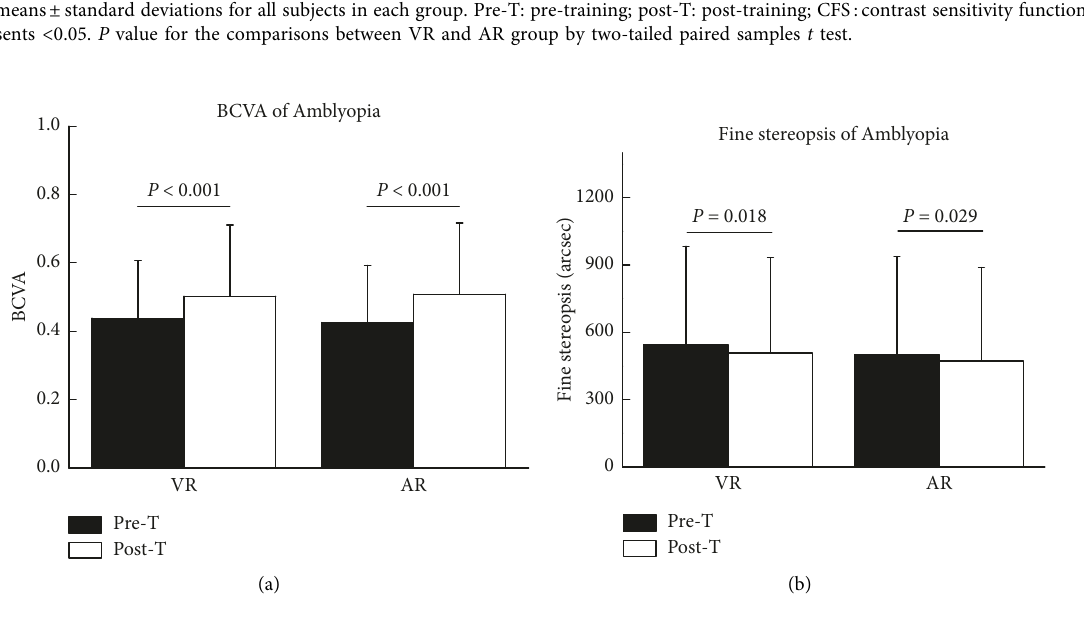
Figure 2: Comparison the BCVA and fine stereopsis between pre- and post-training.